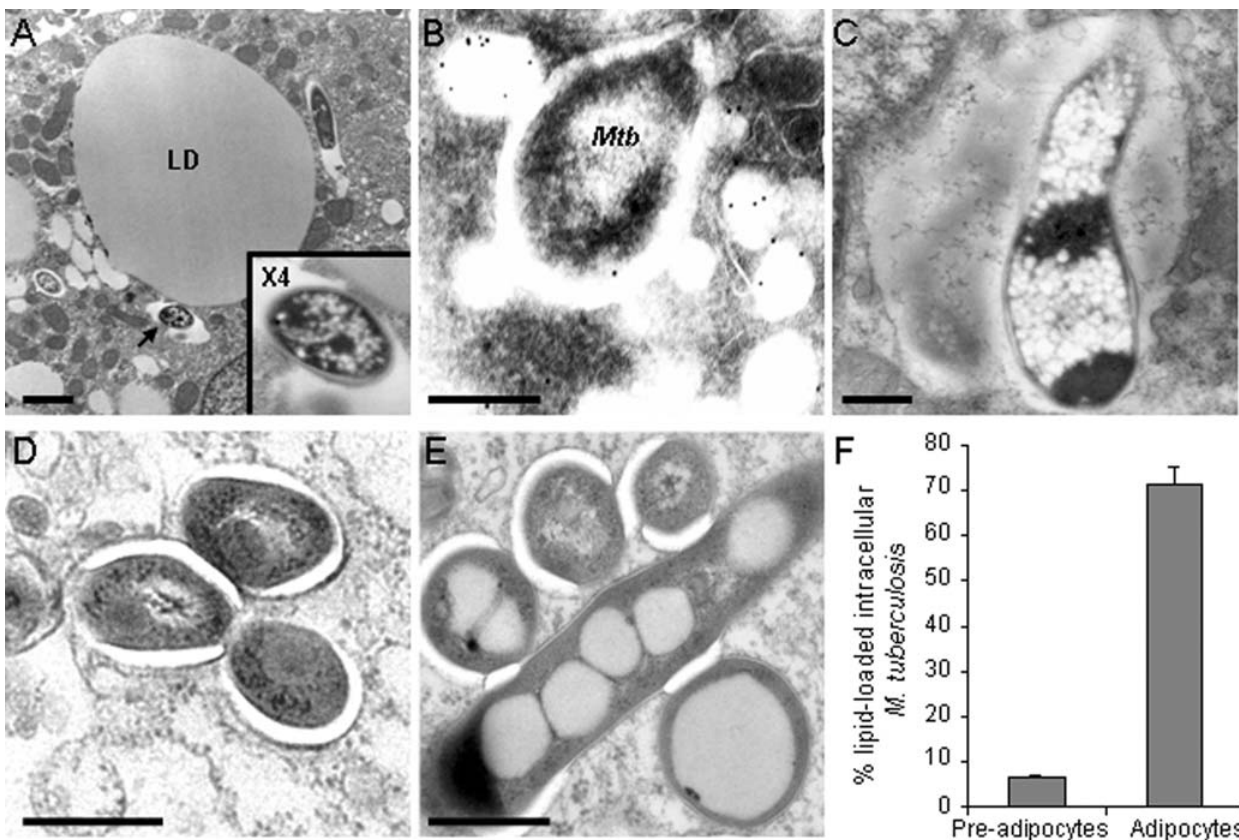
Figure 2.M.tuberculosisaccumulates lipid droplets inside adipocytes. 3T3-L1 mouse adipocytes (A–C&E) and pre-adipocytes (D) were pulsed with M. tuberculosis MT103 at a MOI of 1 for 4 h, then chased with fresh medium for 24 h and observed by electron microscopy. In A., the arrow indicates a mycobacterial vacuole shown at higher magnification in the inset; LD, lipid droplet; bar=2 m m. In B., perilipinA/B was immuno-stained with gold- conjugated antibodies. Mtb , M. tuberculosis ; bar=200 nm. In C, bar=500 nm. In D&E, bar=200 nm. F. Electron micrographs of 2 independent experiments were used to quantified lipid droplet accumulation inside mycobacteria when within adipocytes and pre-adipocytes. An average of 50 mycobacteria were observed in different fields in each sample.